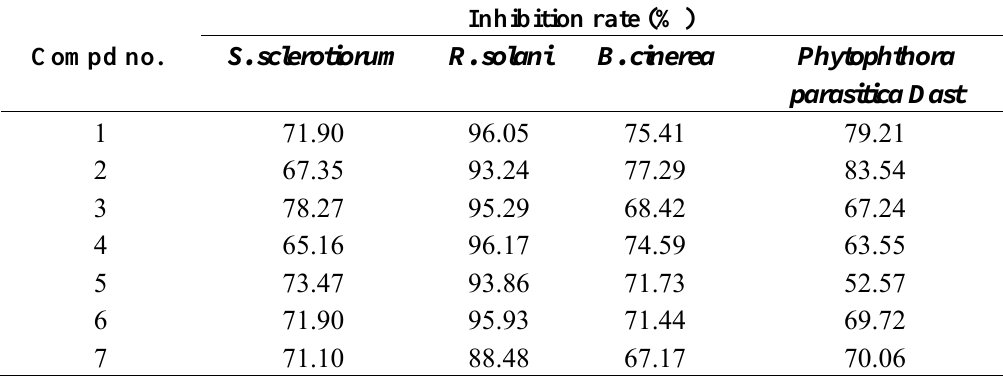
Table 1. Inhibition Rate of Compounds 1-7 against four